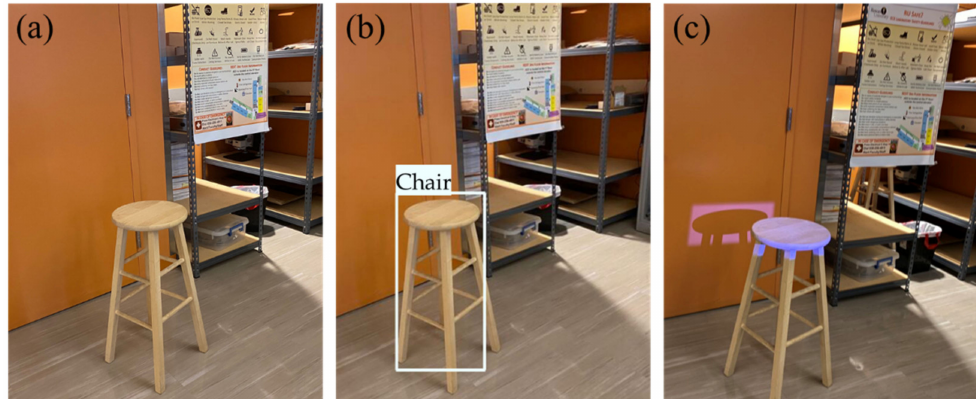
Figure 2. ( a ) Original image of a chair from a regular web/surveillance camera; ( b ) image recognition result with Deep Learning; ( c ) the area that needs to be disinfected is illuminated (violet